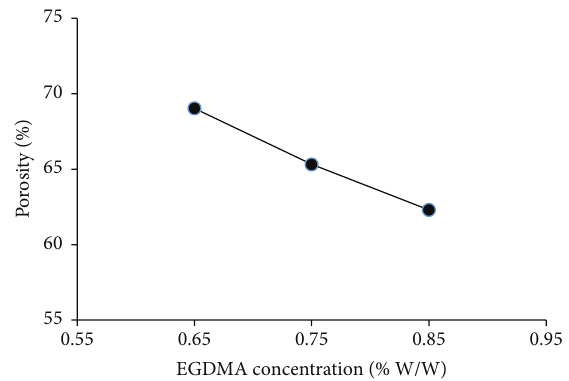
Figure 14: Effect of cross-linking agent (EGDMA) concentration on porosity of AA/Gelatin